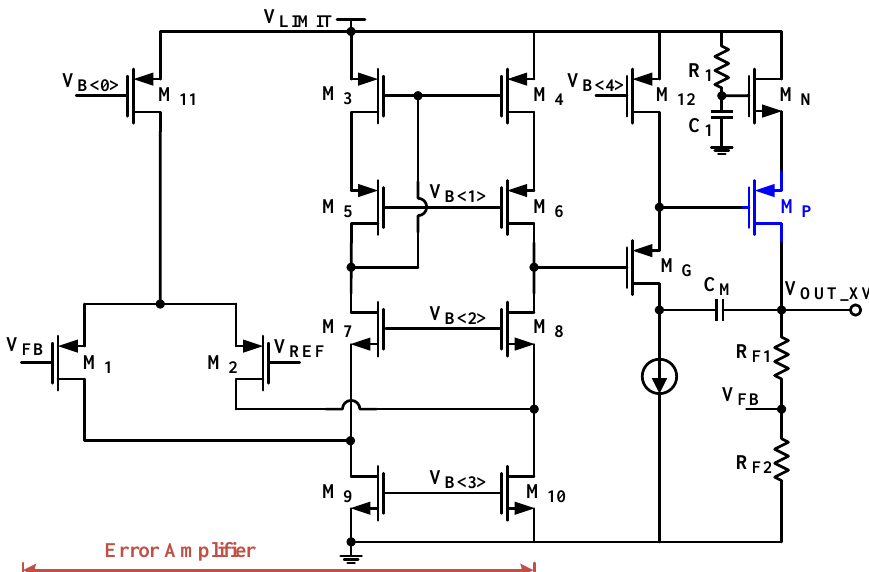
Figure 4. Circuit diagram of the proposed low-dropout regulator (LDO) in the PRC.